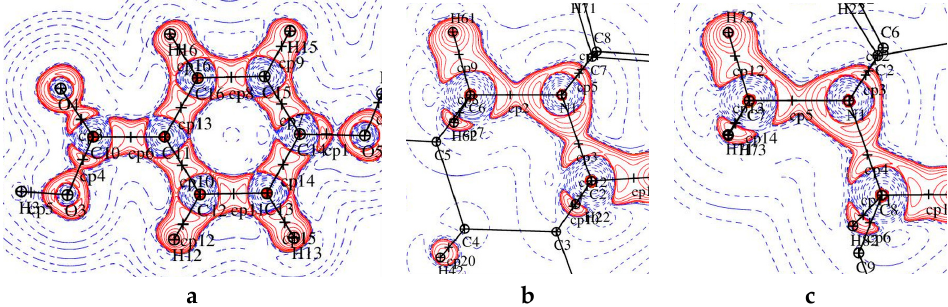
Figure 4. Electron density values [ ρ bcp (e·Å − 3 )] at the covalent bond critical points in 2 ( left ) and graphical representation of bond critical points in molecule 2 ( right ).